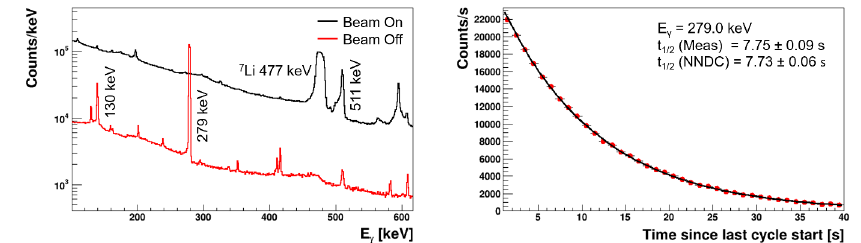
Figure 3. Measurement of the 197 Au( n , n (cid:48) ) 197 m Au reaction. The measured γ -ray spectra is shown with the characteristic peaks at 130.2 and 297.01 keV. Note the reduction in background between the irradi- ation and counting cycles due to the beam pulsing system. The decay curve of 197 m Au is also shown, with a preliminary t 1 / 2 = 7 . 73 ± 0 . 06